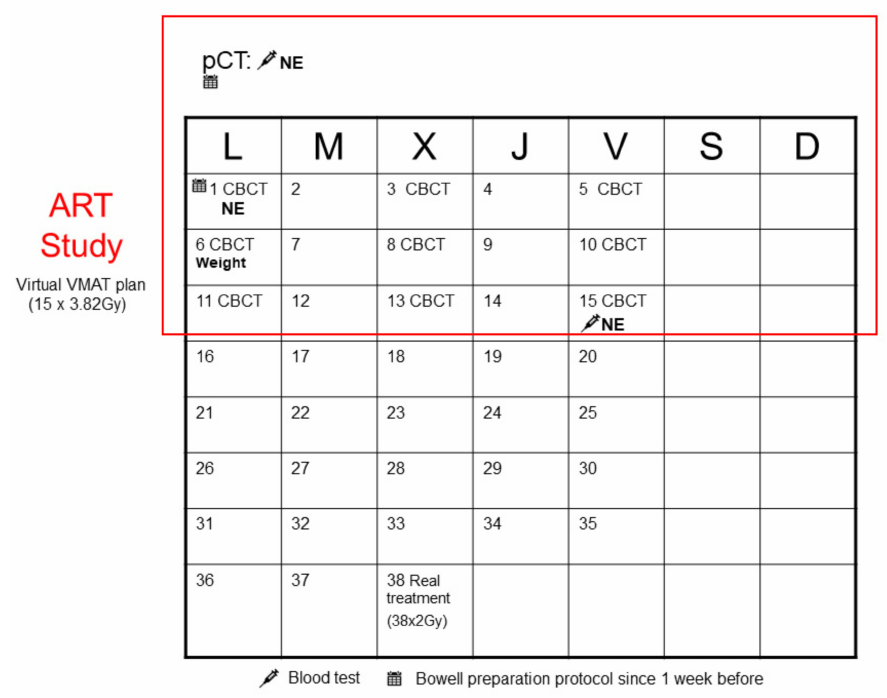
Figure 2. Study design. pCT: planning CT; VMAT: volumetric-modulated arc therapy; ART: adaptive radiotherapy; CBCT, cone-beam computed